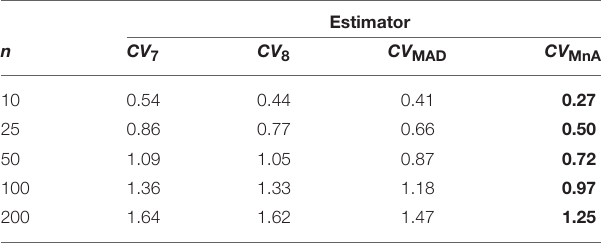
TABLE 5 | Median values of log 10 ( γ ) accuracy metric across θ produced for each estimator and sample sizes under the Binomial